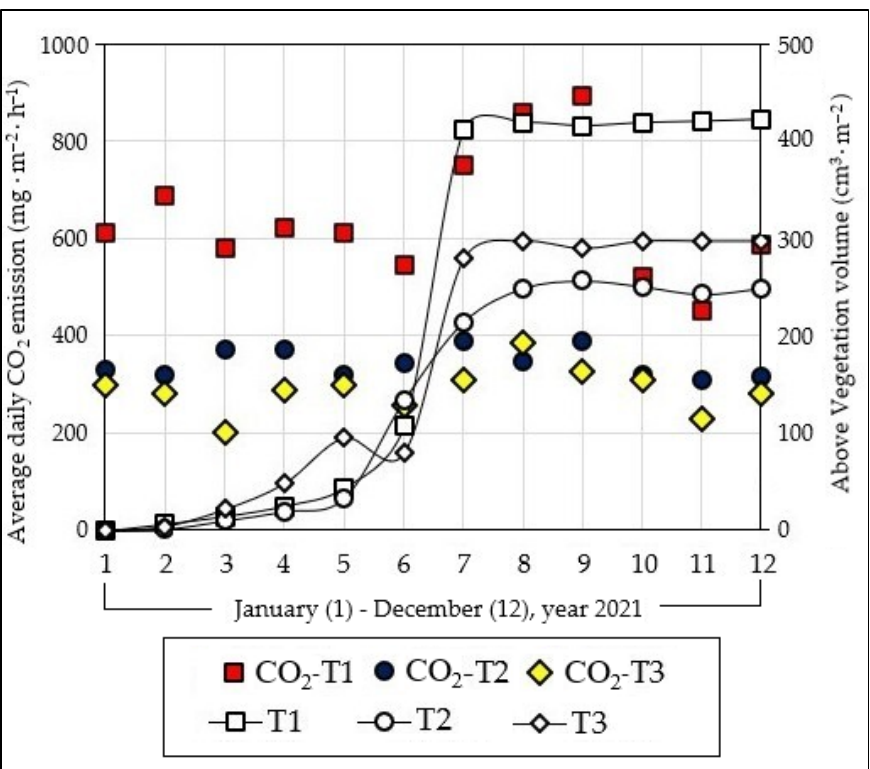
Figure 3. Temporal trend and comparison between the aboveground vegetation volume (cm 3 per m 2 ) and CO 2 emissions (mg·m −2 ·h −1 ) documented in the three transects during the experimental campaign. Red squares, blue circles, and yellow diamonds are the average values of CO 2 emissions observed in T1, T2, and T3, respectively, during 2021. White squares, circles, and diamonds are average values of the aboveground vegetation volume of Phragmites australis documented in 2021. Table 1. Average concentrations and removal efficiencies with standard deviation (±SD) of the phys- icochemical parameters detected at the inflow (in) and outflow (out) of the HF-TW during the ex- perimental period (January – December 2021).